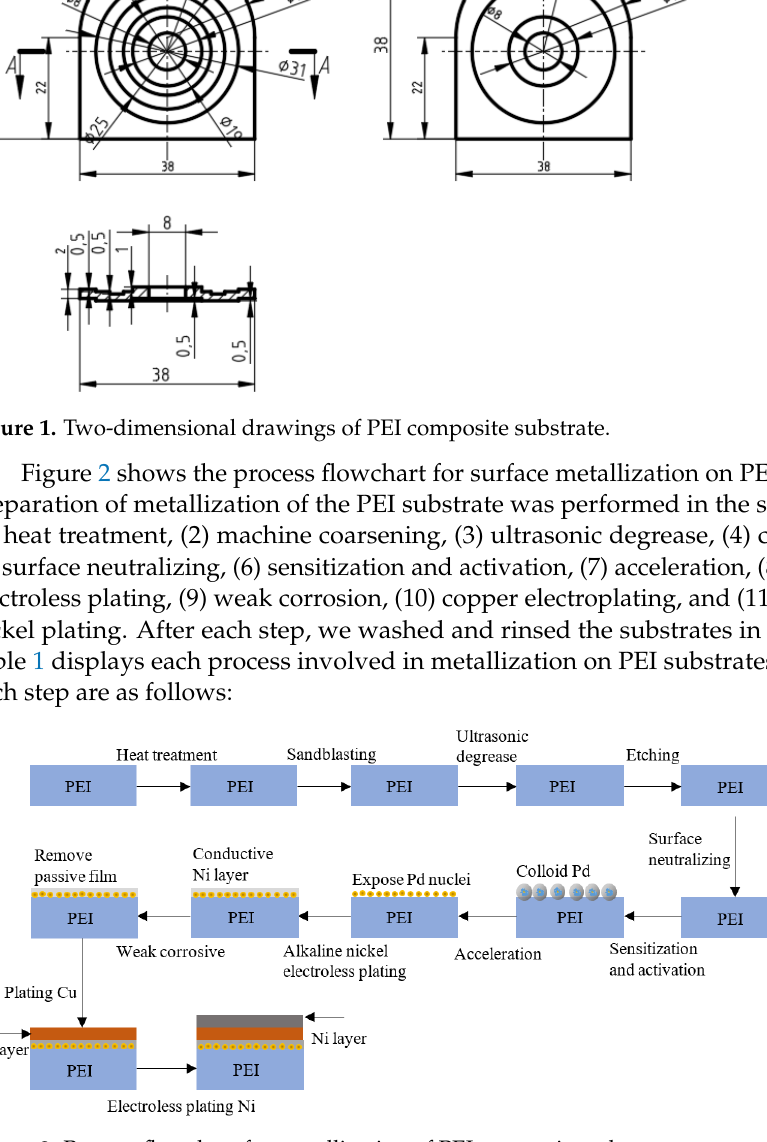
Figure 2. Process flowchart for metallization of PEI composite substrates.